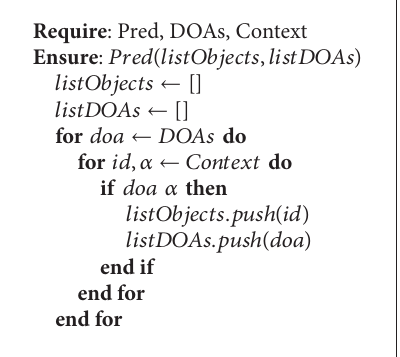
Algorithm 2: Implementation algorithm for the interpretation of DOAS